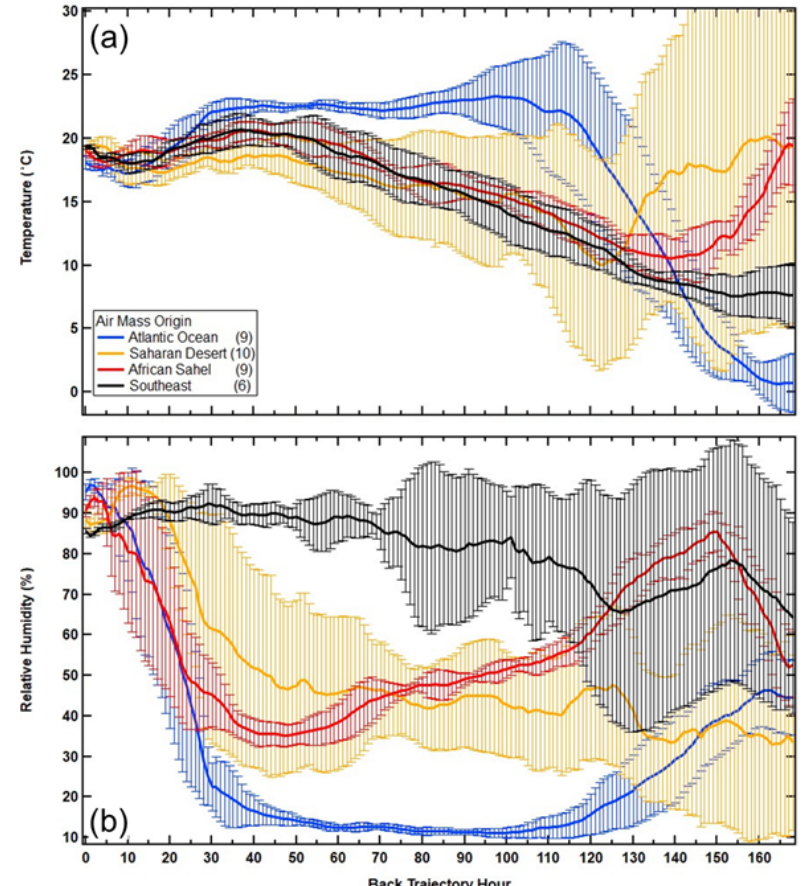
Figure 9. The 7d HYSPLIT back-trajectory analysis of average (a) temperature and (b) relative humidity. The vertical bars are standard deviations around the averages. The numbers in parentheses after the trajectory labels are the number of consecutive trajectories that were averaged for each air mass